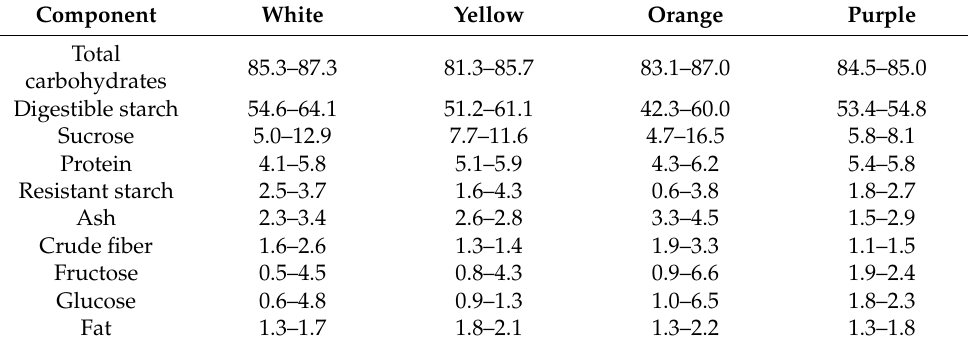
Table 2. Nutrient composition of SP of different flesh colors 1 . Component White